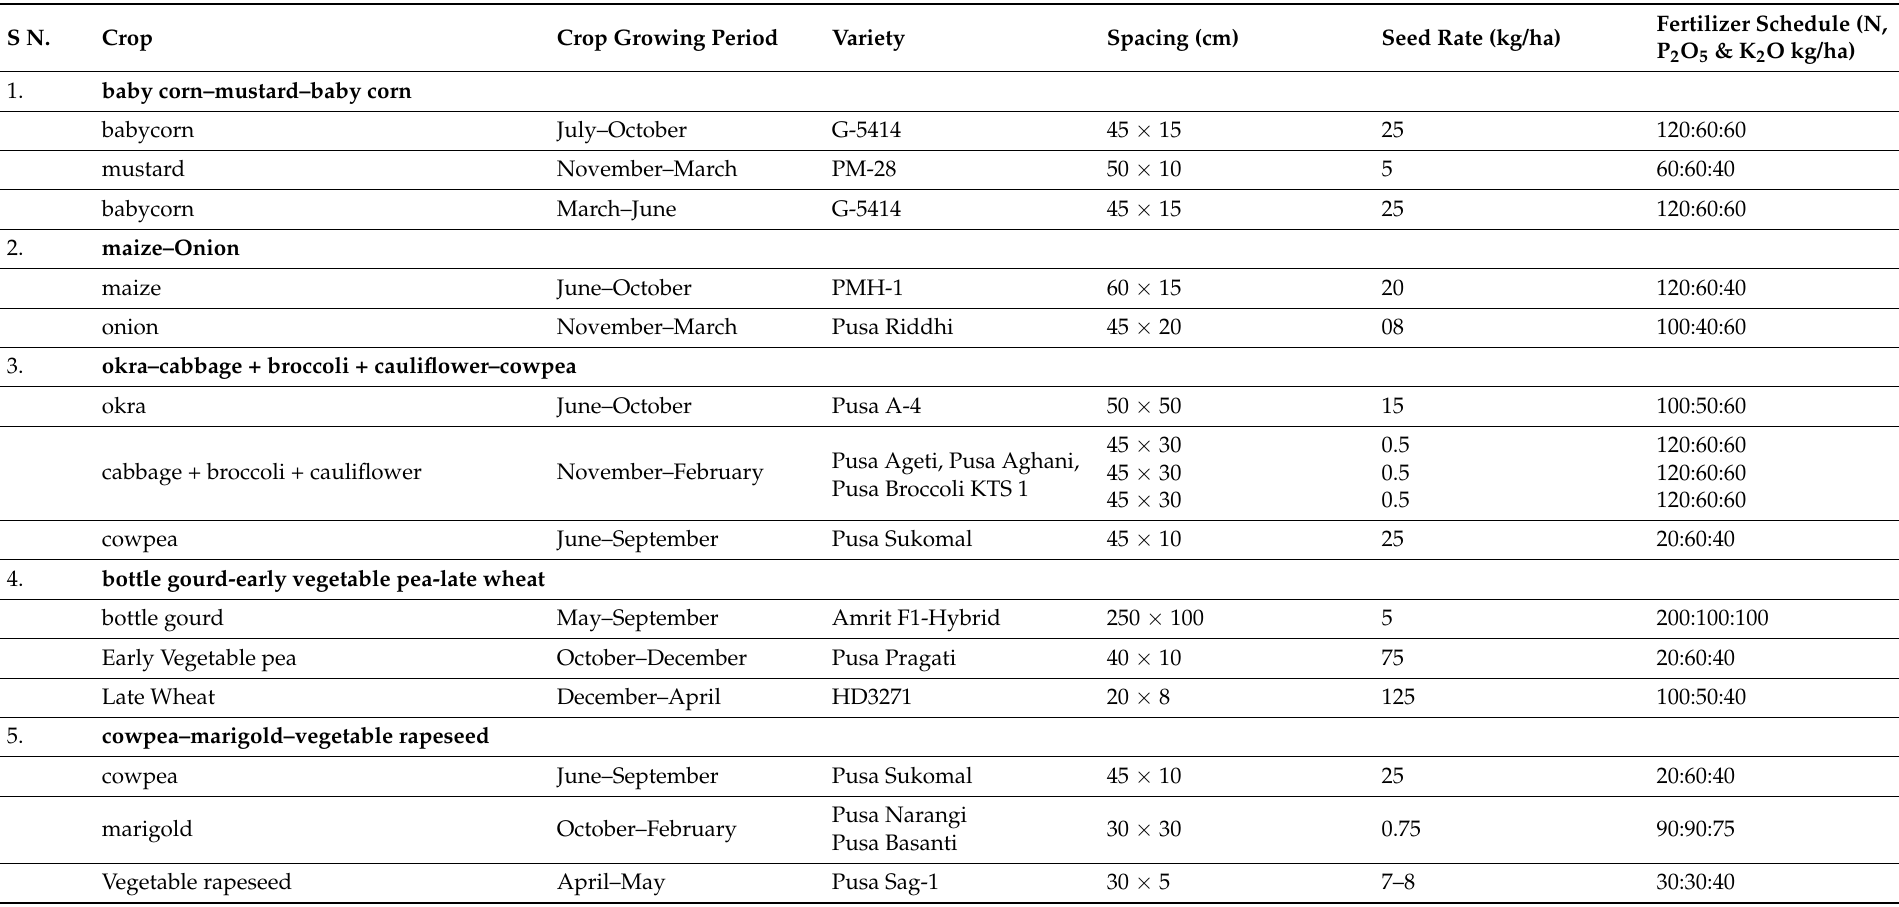
Table 3. Crops, varieties, spacing, and fertilizer schedule adopted for cropping systems trial. Crop Growing Period